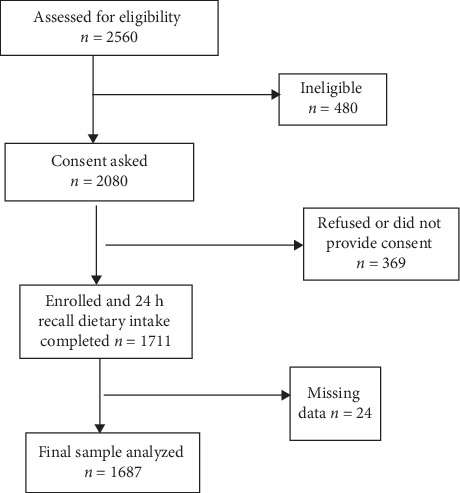
Flowchart of participant progression through the dietary survey across 4 districts.